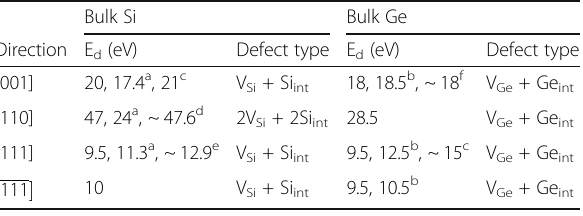
Table 1 The calculated threshold displacement energies and associated defects after the recoil events in bulk Si and Ge. V X : X vacancy ( X = Si or Ge); X int : X interstitial ( X = Si or